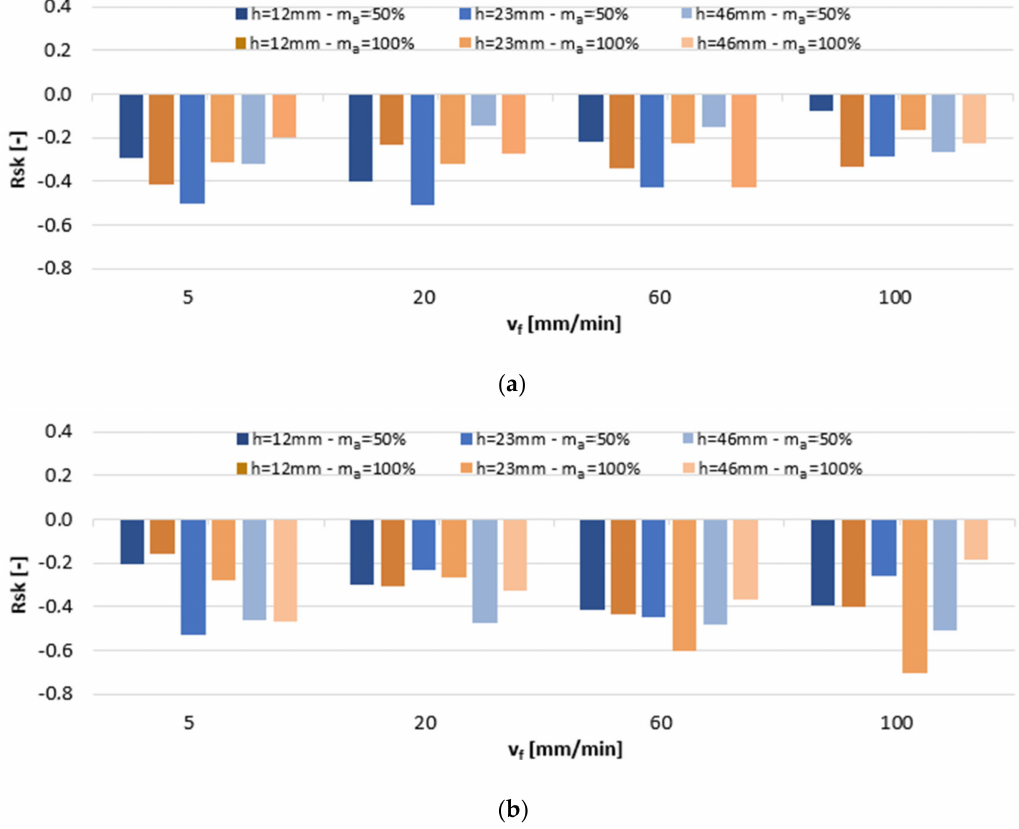
Figure 6. The impact of jet feed rate v f , sample height h, and abrasive flow rate m a on Rsk of post-machined alloys: ( a ) AlSi10Mg and ( b )